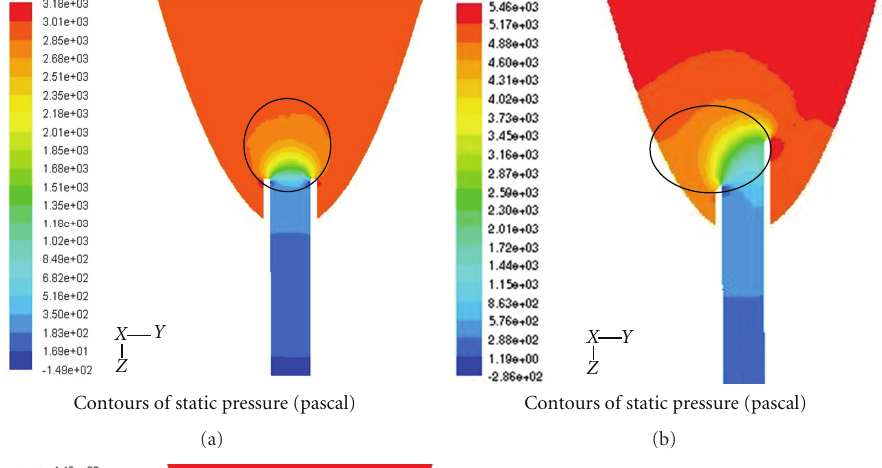
actually, these factors may change the flow distribution in LV and inflow cannula and eventually cause the suction,